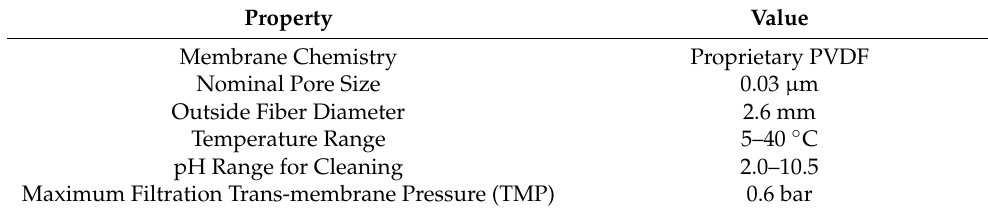
Table 3. Commercial PVDF hollow fiber UF membranes (PURONR MBR, Koch Separation